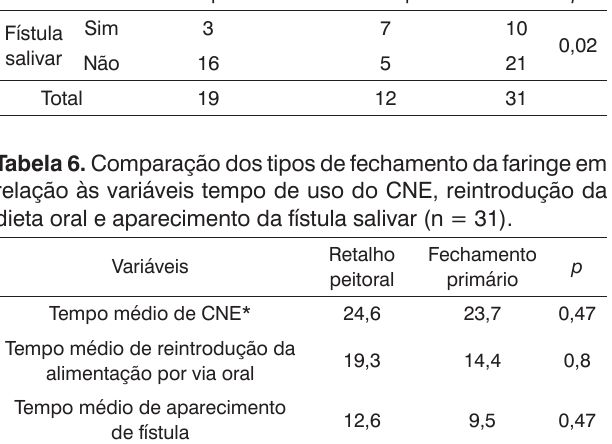
Tabela 5. Incidência de fístula salivar: comparação entre retalho peitoral e fechamento primário. Variáveis